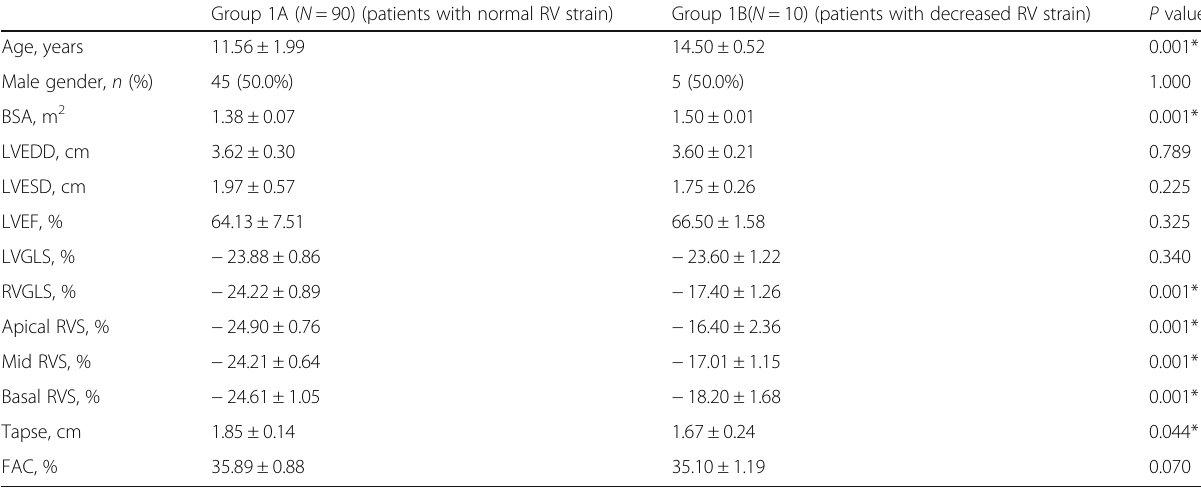
Table 4 Basal characteristics, echocardiographic results, and RV 2DSTE of group 1 subgroups at 20 weeks of receiving chemotherapy Group 1A ( N = 90) (patients with normal RV strain) Group 1B( N = 10) (patients with decreased RV